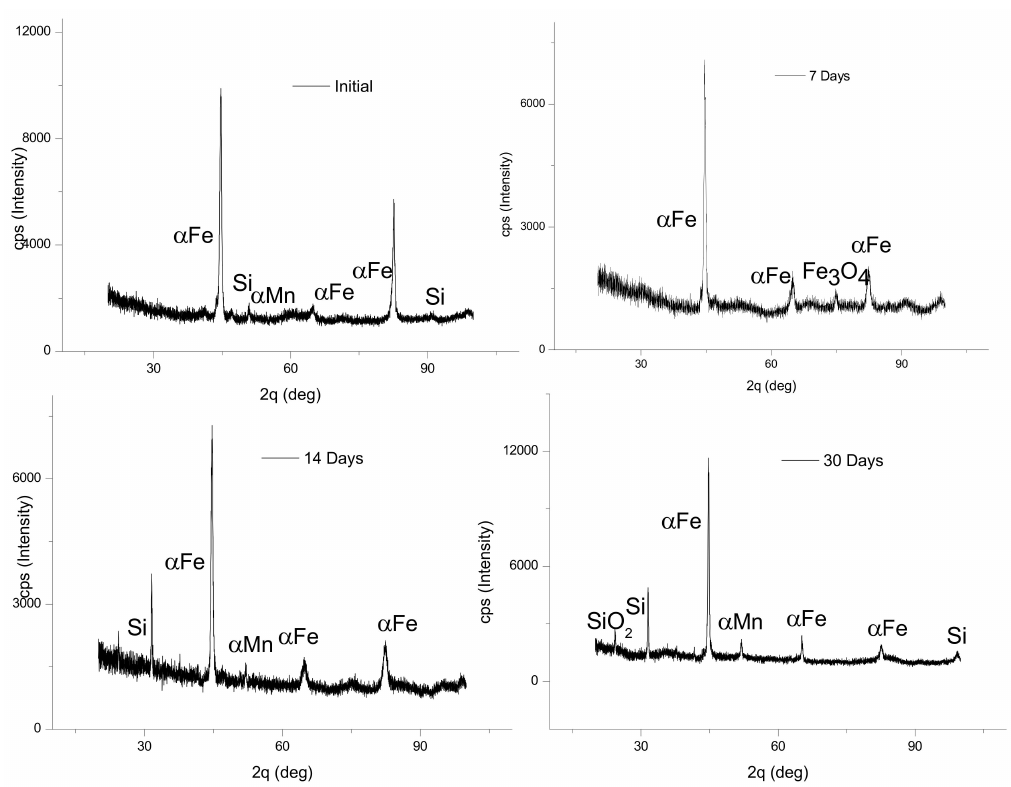
Figure 4. X-ray diffraction (XRD) graph of the FeMnSi + MgCa alloy’s initial state and after different immersion periods in simulated body fluid (SBF)